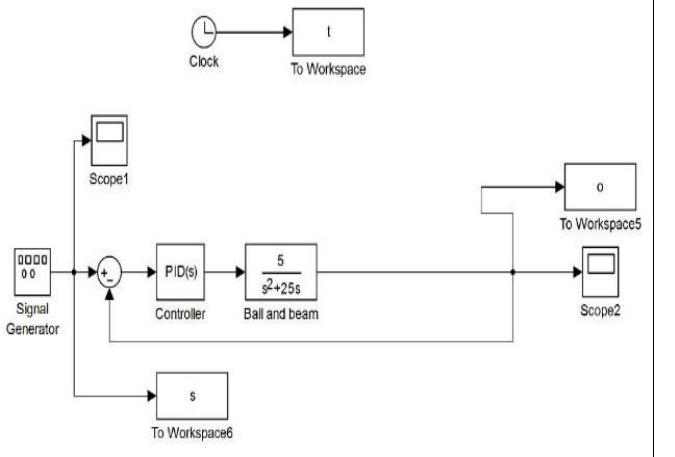
Figure 10: Set-point simulation model.